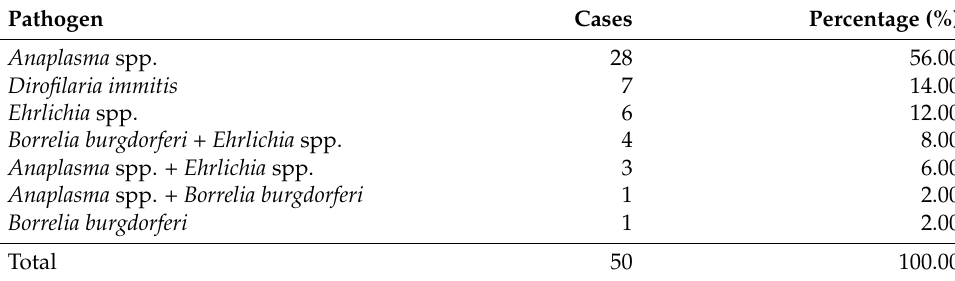
Table 6. Vector-borne pathogens in MWDs with positive SNAP ® 4Dx ® test.